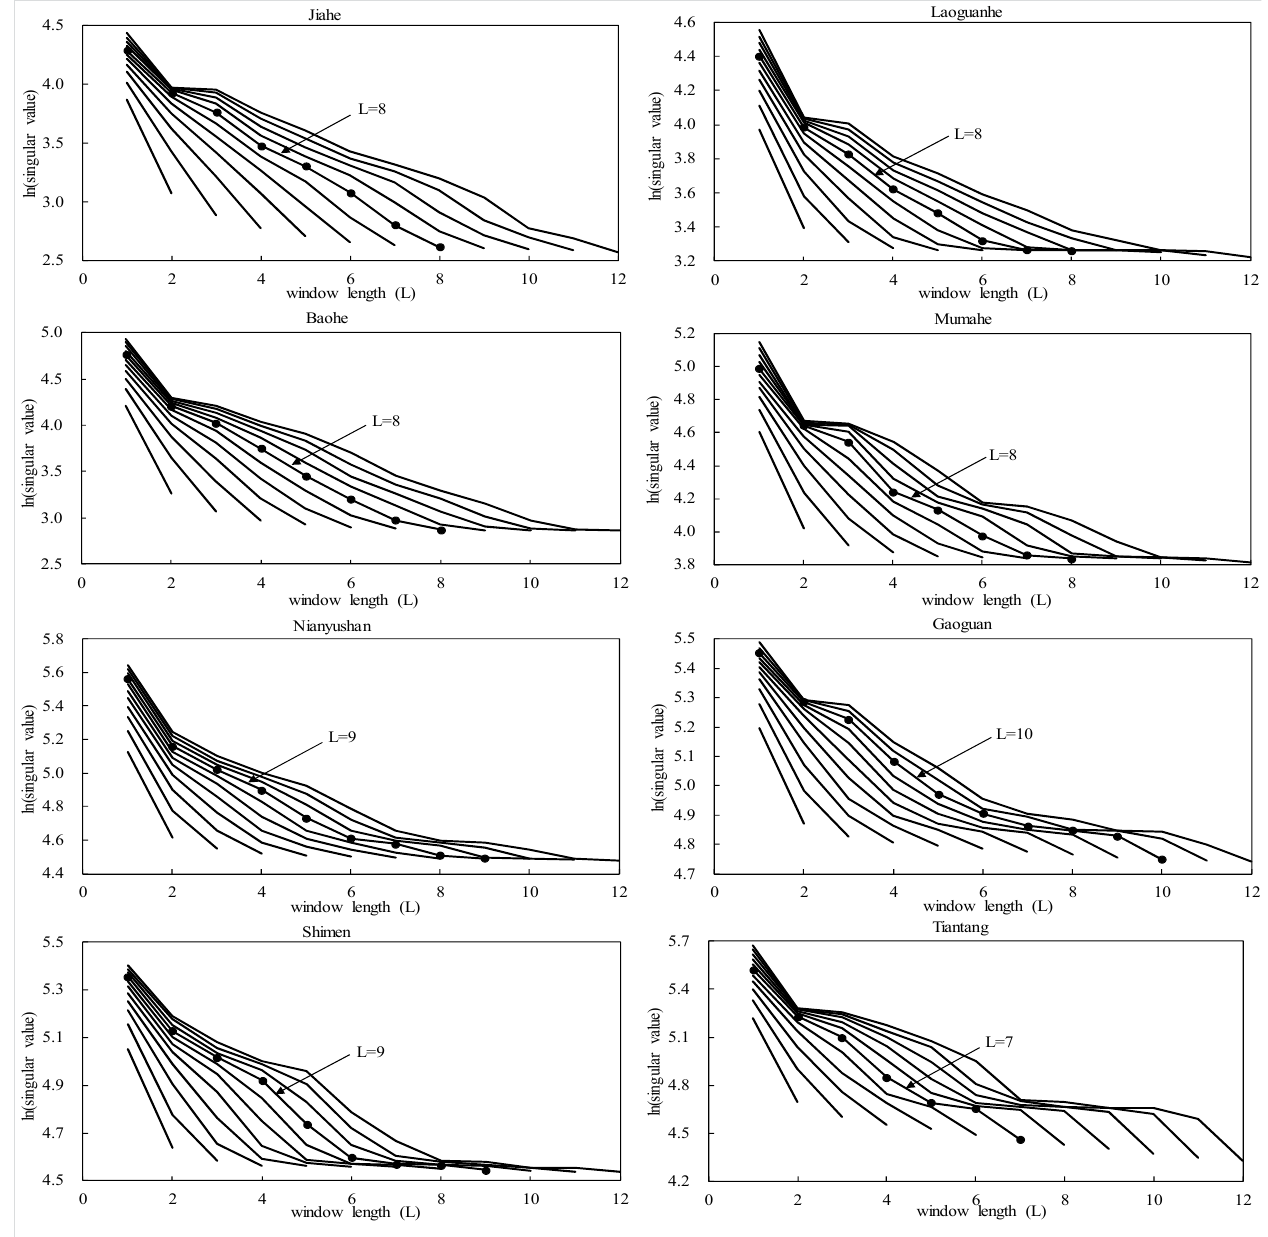
Figure 4. Singular values as a function of different window length L for rainfall